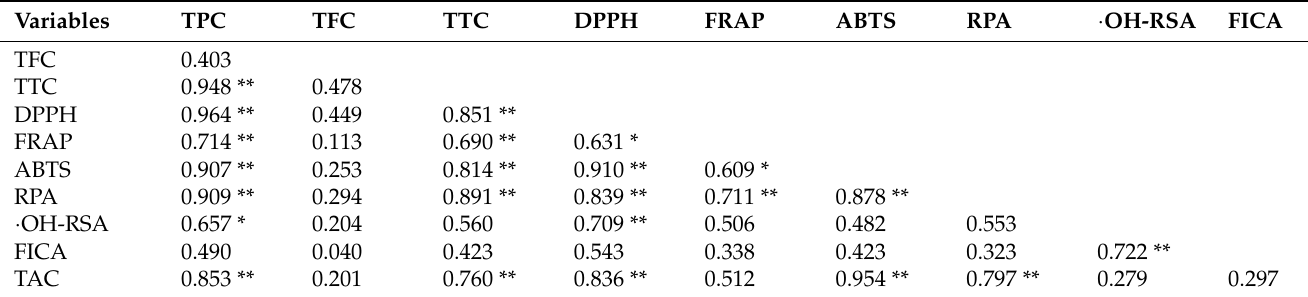
Table 2. Pearson’s correlation coefficient (r) for the relationships between assays for antioxidant capacity and phenolic